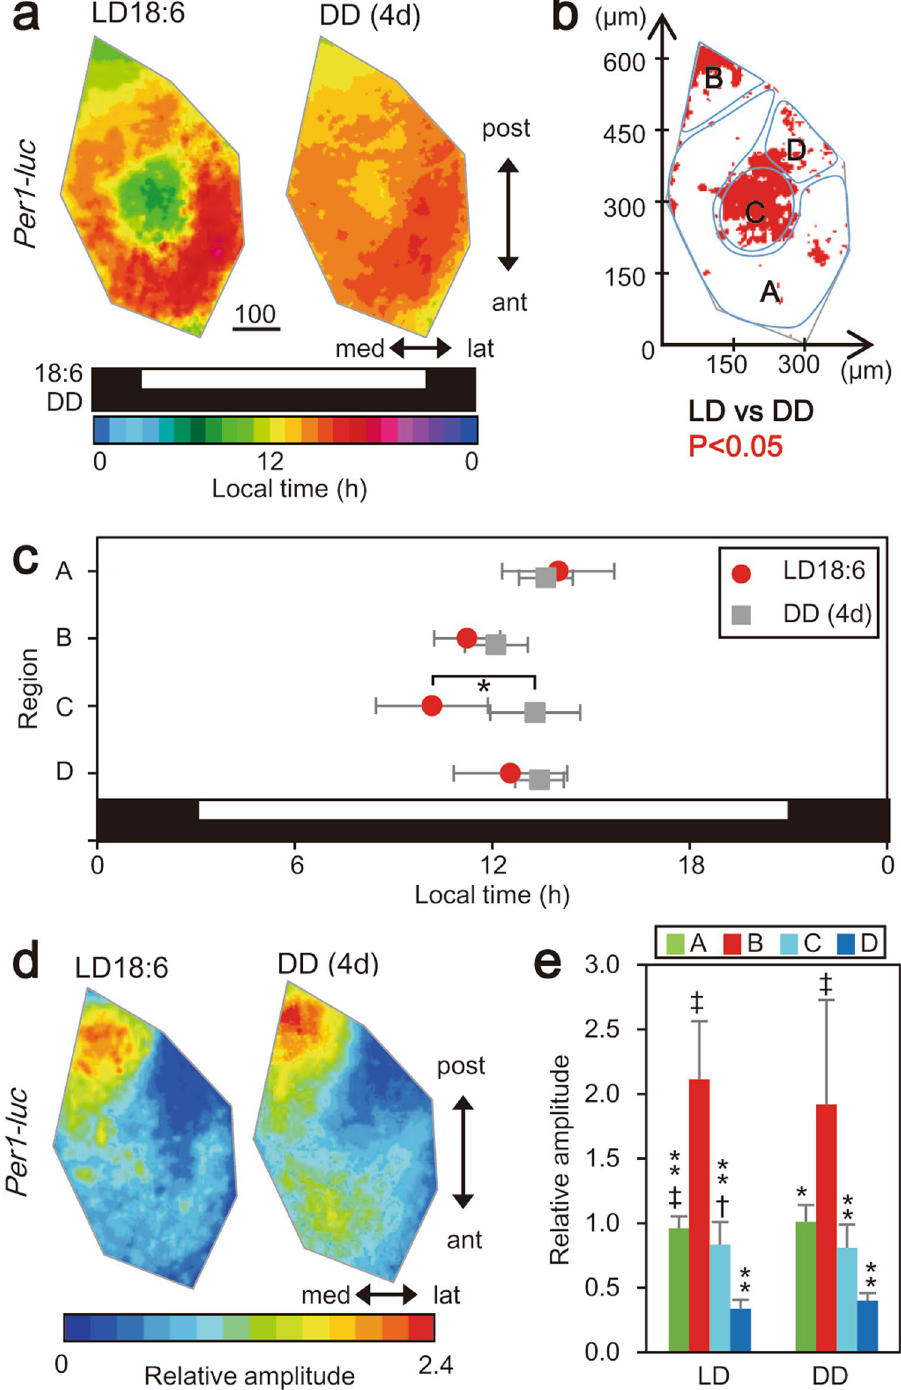
Figure 6. A blunted regional difference in acrophase of Per1-luc rhythm by exposure to constant darkness. ( a ) Mean acrophase maps for the circadian Per1-luc rhythm of the mice exposed to LD18:6 (left, n = 8) and of the mice exposed to DD for four days (DD (4d)) after LD18:6 (right, n = 7). Scale bar, 100 μ m. Horizontal black and white bars indicate light and dark phases of photoperiod; the upper LD 18:6 and the lower DD. A color bar indicates local time. ( b ) Statistical significance of phase differences between LD18:6 and DD (4d) is demonstrated in an SCN map. Red marks indicate the pixel s with significant phase difference (t-test, P < 0.05). ( c ) Mean acrophases with SD in the four SCN regions (Fig. 3e) in LD18:6 (red circle) and DD (grey square). * P < 0.01, vs LD18:6, two-way ANOVA with a post-hoc Tukey-Kramer test. ( d ) Mean amplitude maps in LD18:6 and DD (4d). Color bars indicate relative amplitudes. See also the legend of Fig. 5. Scale bar, 100 μ m. ( e ) Mean relative amplitudes with SD in the four SCN regions. ** P < 0.01, * P < 0.05, vs. region B, ‡ P < 0.01, † P < 0.05 vs. region D, one-way ANOVA with a post-hoc Tukey-Kramer